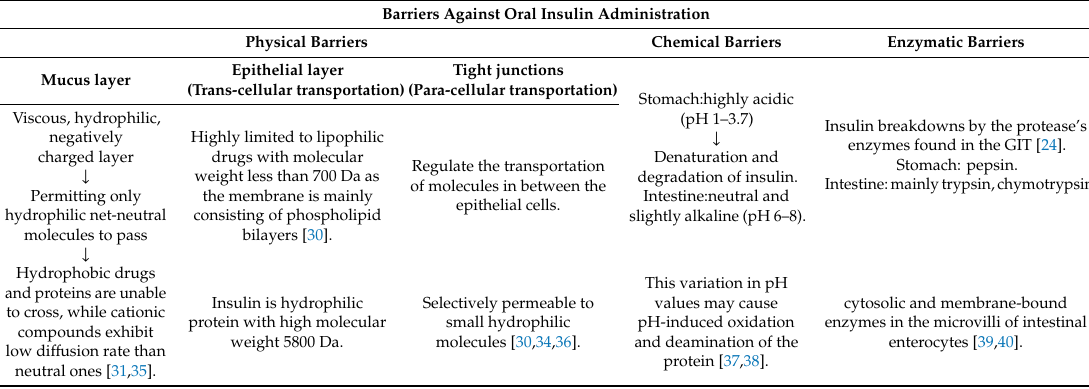
Table 1. E ff ects of di ff erent barriers in gastrointestinal tract (GIT) against insulin oral delivery.